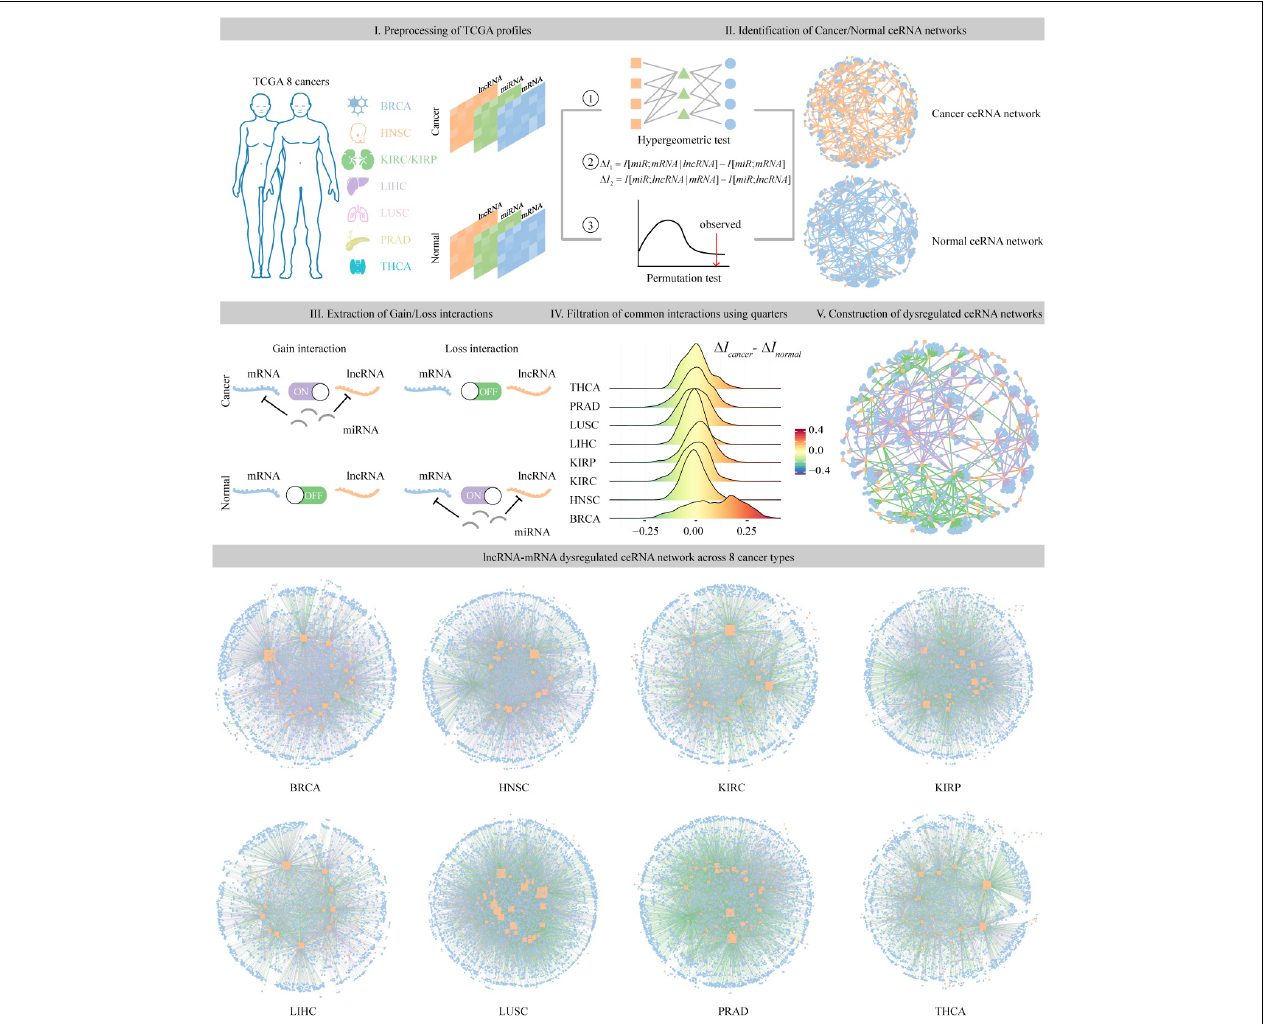
FIGURE 1 | The pipeline of identification and construction of dysregulated ceRNA networks across eight cancer types. Step I: preprocessing of lncRNA, miRNA, and mRNA expression profiles from TCGA eight cancer types. Step II: identification of cancer and normal ceRNA networks using the method described in section “Materials and Methods.” Step III: extraction of ceRNA pairs that specifically existed in the cancer or normal samples. Step IV: filtration of common ceRNA pairs that occurred in both conditions using upper and lower quarters. Step V: assembling all the gain and loss interactions to construct dysregulated ceRNA